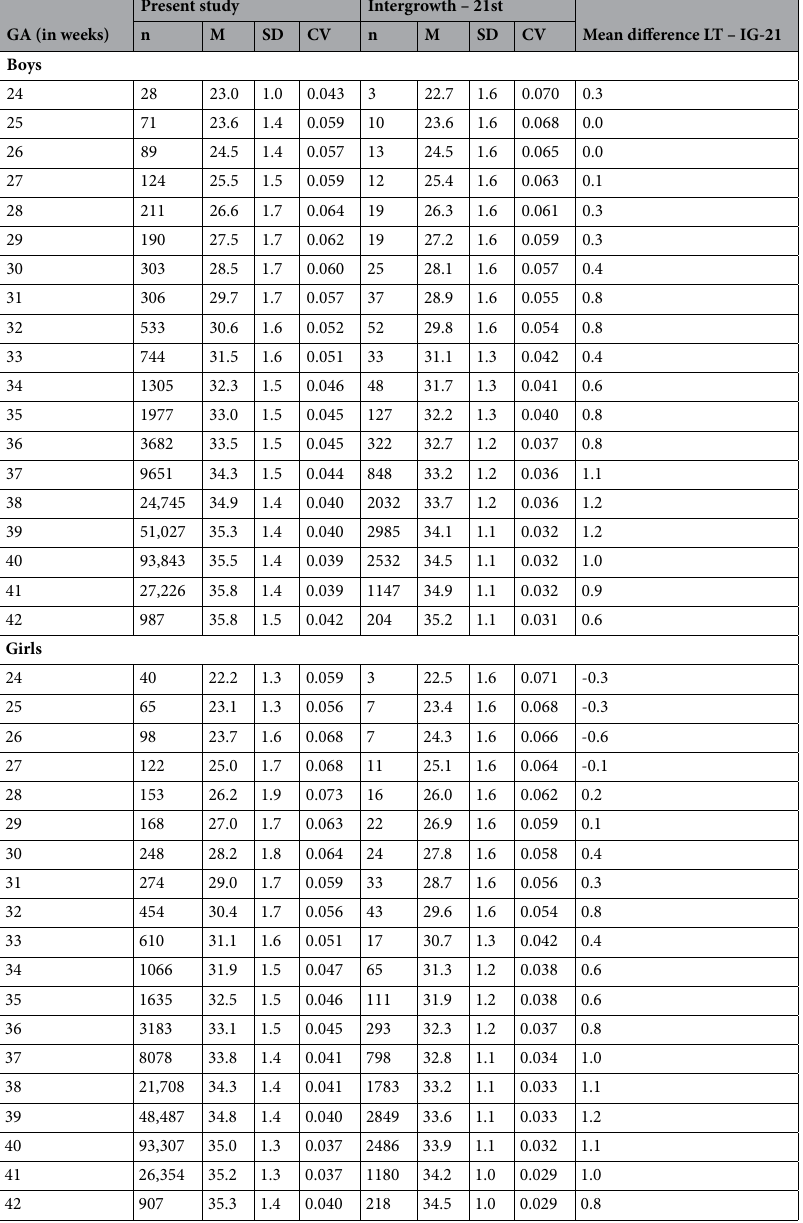
Table 1. Comparison of head circumference (HC) of Lithuanian newborns by sex and gestational age (GA) and the INTERGROWTH-21st (IG-21) reference 19,24 . n—count, M—mean, SD—standard deviation, CV— coefficient of variation, defined as standard deviation /